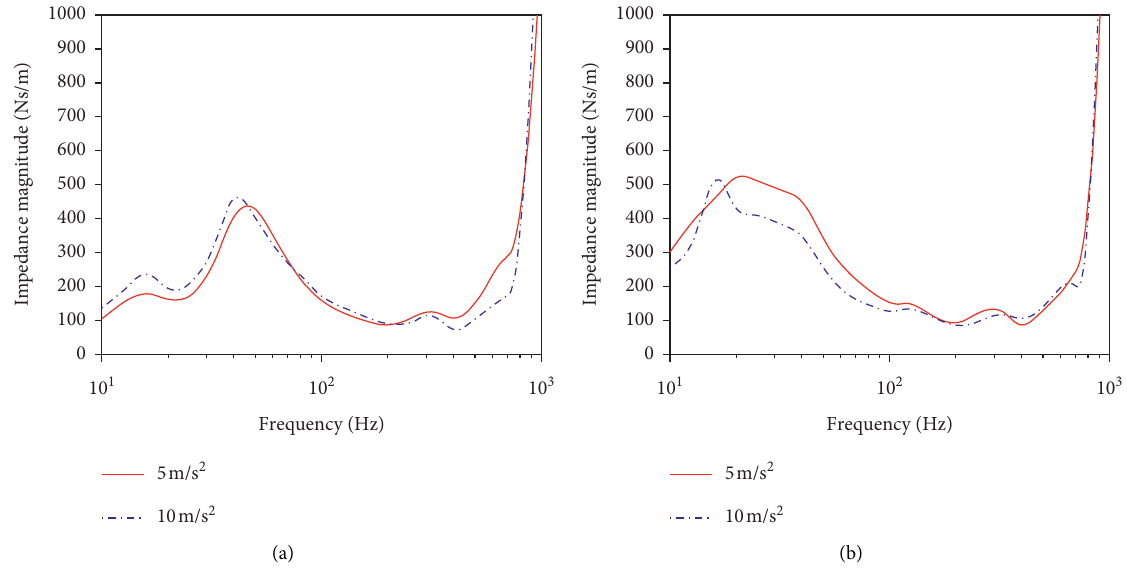
Figure 11: Amplitude of mechanical impedance of the hand-arm system under different vibration magnitude (30N grip force and 30N push force). (a) 90 ° elbow angle. (b) 180 ° elbow